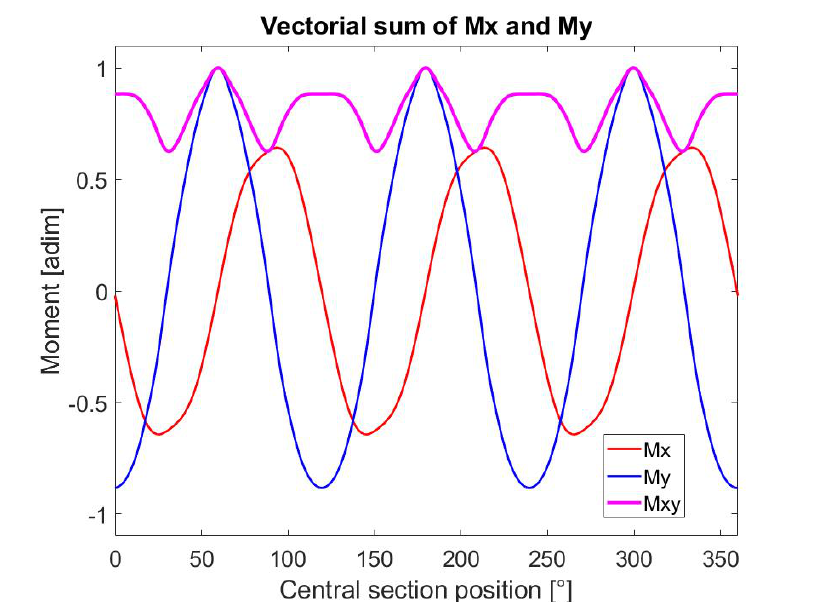
Figure 18. Estimation of moments in x (red line) and y (blue line) direction and their vector composition (magenta). The resultant shows six peaks on each cycle. Magnitude is